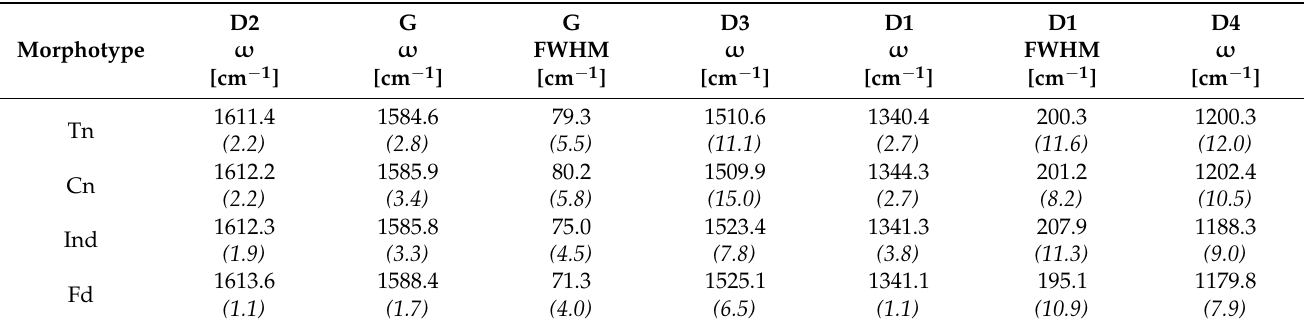
Table 6. Position and full width at half maximum (FWHM) of the Raman bands in the spectra of the studied morphotypes.